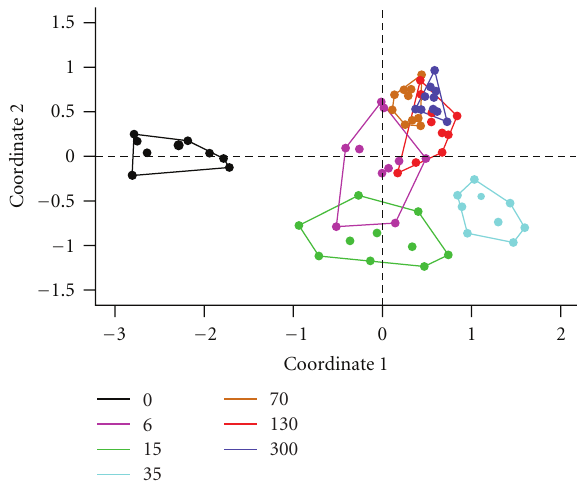
Figure 8: Plot of nonmetric multidimensional scaling (NMDS) ordination, showing di ff erence between areas: stress 0.1401; P < 0 . 001. Colors correspond to regeneration time, varying from 0 to 300